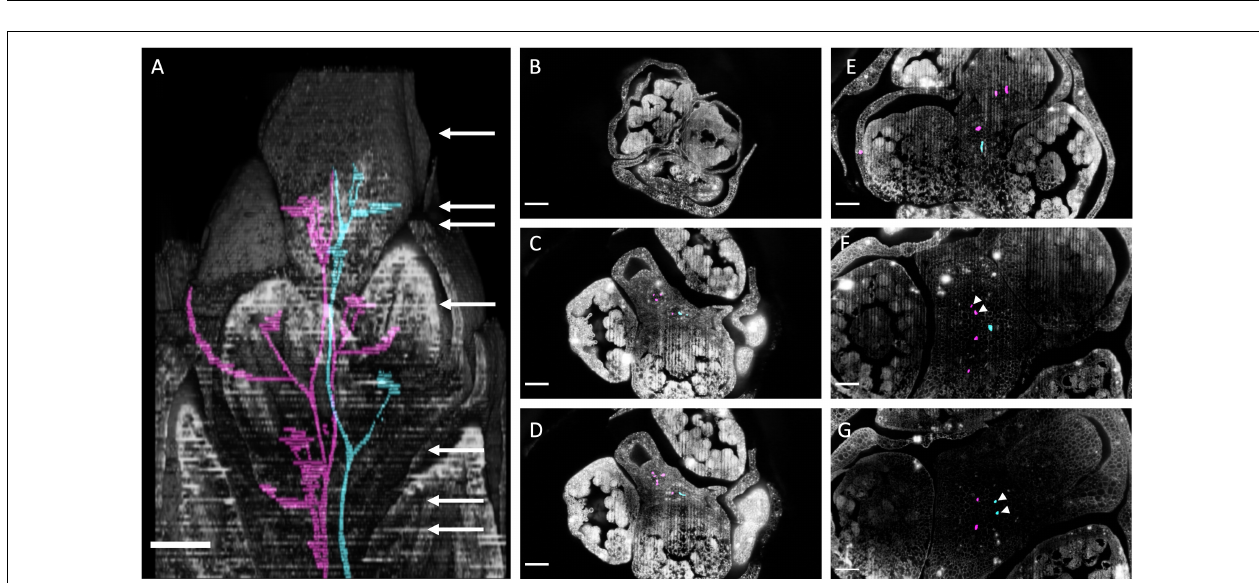
FIGURE 12 | Ornithogalum umbellatum inflorescence anatomy by laser ablation tomography. (A) Inflorescence reconstructed from serial sections at 30 um increments overlayed with two vascular bundles (cyan and magenta). White arrow corresponds to the individual section, in descending order, shown in the following panels. (B–G) Individual anatomical panels, in grayscale. White arrowheads indicate when vascular bundles from distinct flower pedicel merge. Scale bar of all images: 250 µ m.